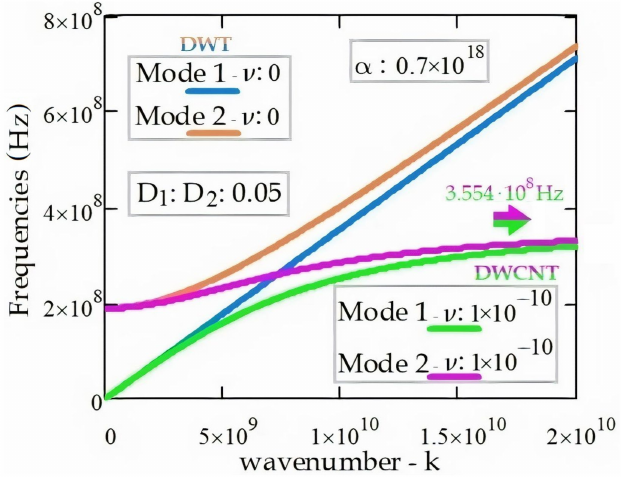
Figure 8. The EM wave dispersion relations (k, ω ) related to DWT and